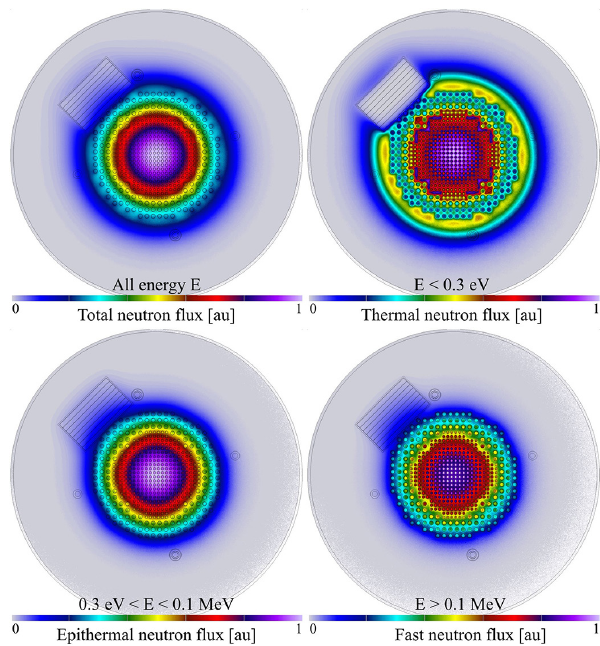
Fig. 4. Radial neutron flux in linear scale for different ranges: total (top-left), thermal (top-right), epithermal (bottom-left) and fast (bottom-right). The axial position used to score the flux corresponds to a 10cm width gate centered around the PETALE